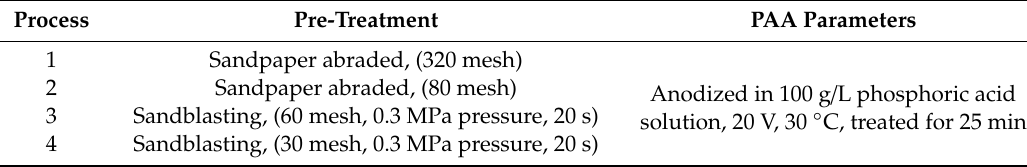
Table 3. Experimental parameters of combined